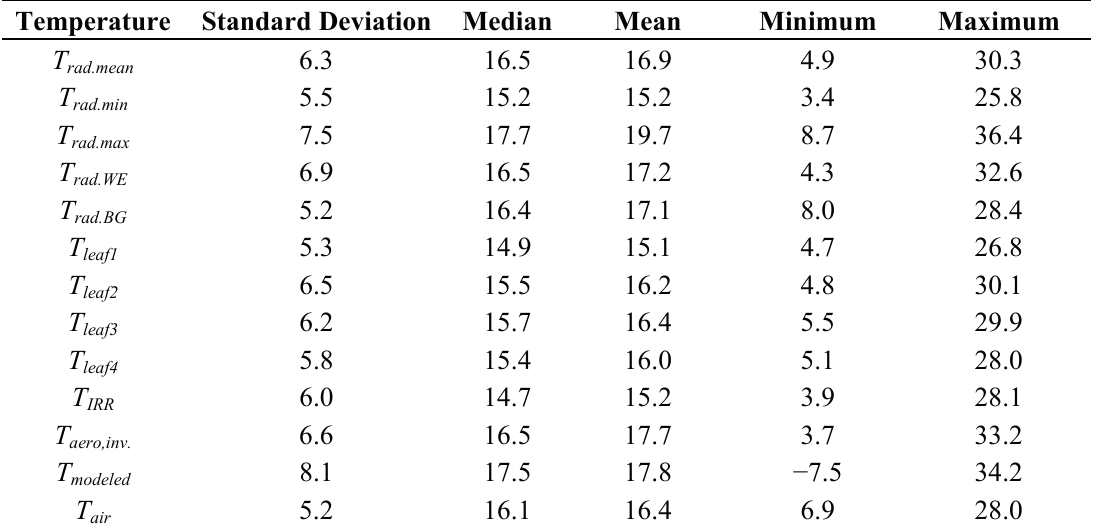
Table 2. Statistics of the 30-minute interval aggregated surface temperatures ( T , °C) derived = average; T = minimum; T = maximum; from thermal imagery ( T rad,mean rad,min rad,max T = temperature of the deeper shaded areas and underlying soil; T = temperature of rad,BG rad,WE wheat ears), from Thermocouples 1–4 ( T ) and from the IR radiometer ( T ), of the leaf IRR inverted aerodynamic temperature ( cf. Section 3.2) ( T ) and the modeled surface aero,inv , cf. Section 3.1.2); number of observations = temperatures ( T modeled